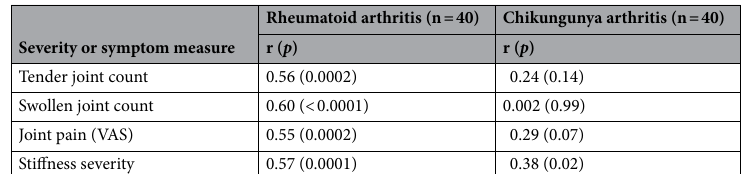
Severity or symptom